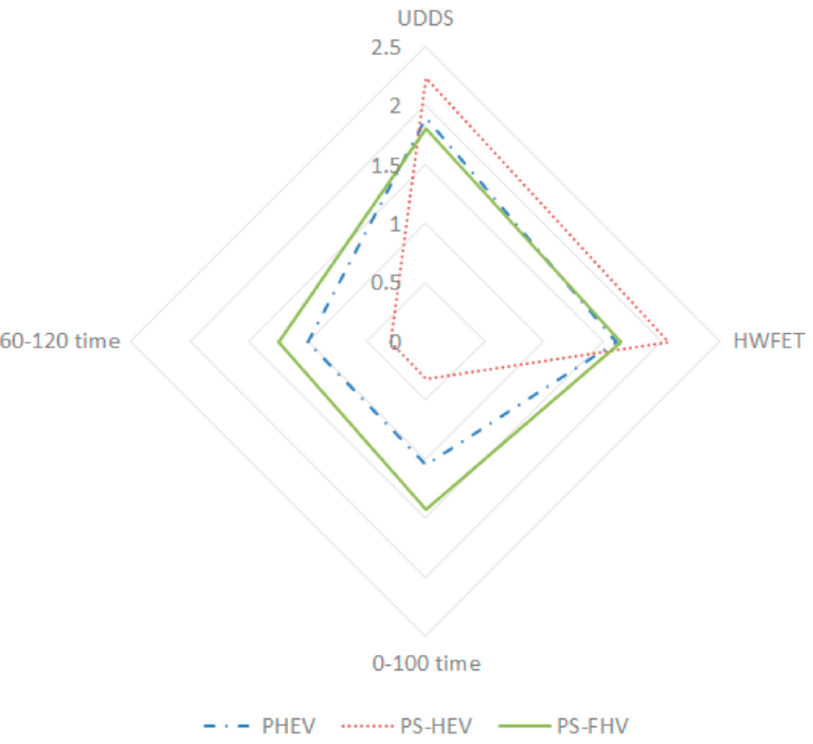
Figure 27. Performance comparison of the proposed flywheel hybrid powertrain with other powertrain types.